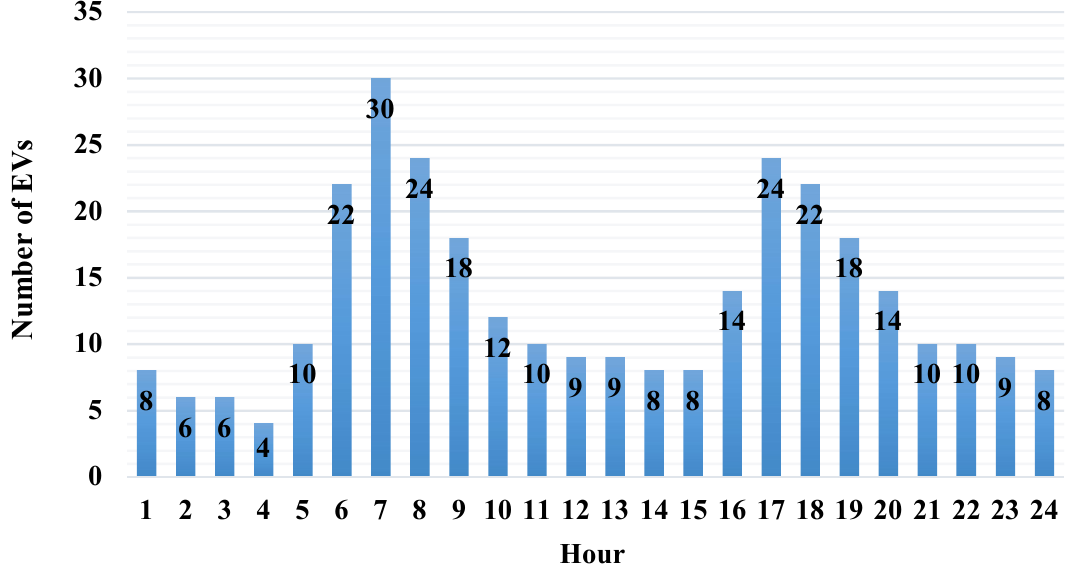
Figure 6. Hourly EVs entering the FCS for charging.